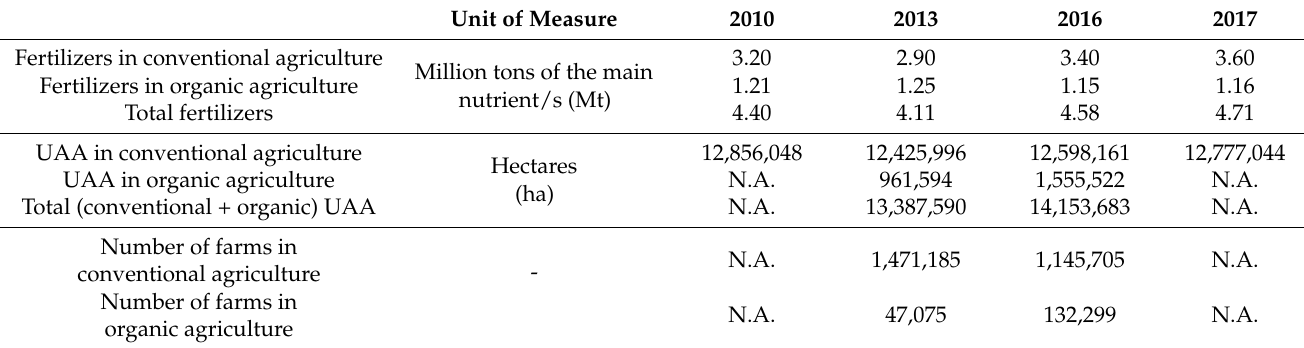
Table 4. Fertilizer distribution, Utilized Agricultural Area (UAA) and number of farms in conventional and in organic agriculture, in 2010, 2013, 2016, and 2017 in Italy. Total fertilizers include all types of fertilizers (see Table